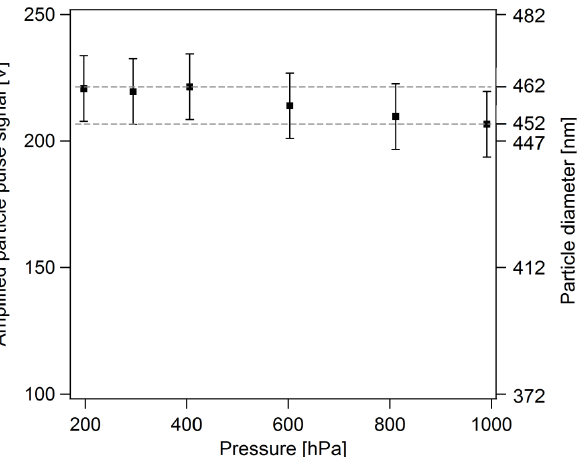
Figure 7. Particle signal pressure dependency of the CARIBIC OPSS for 450nm PSL particles. Error bars indicate plus/minus one size bin uncertainty (out of 230 in total) in the determination of the peak distribution